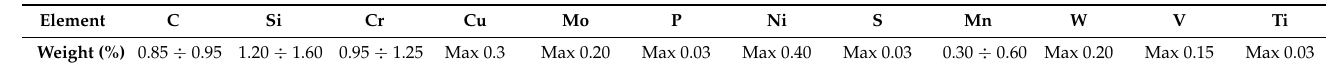
Figure 1. Experimental setup. Table 1. Chemical composition in % of 90CrSi steel (DIN 17350-80).